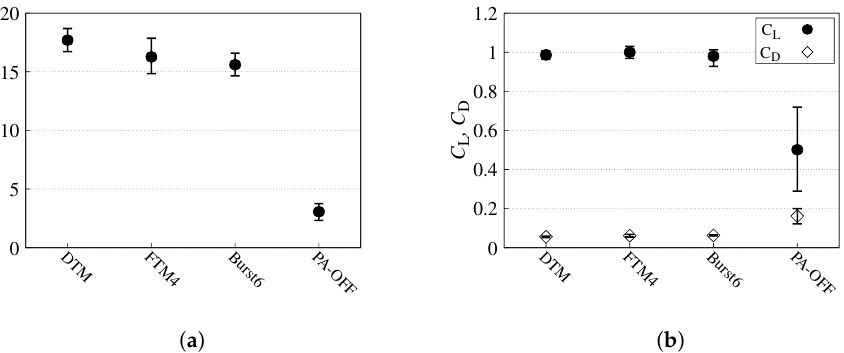
Figure 15. Aerodynamic characteristics in the DTM, FTM4, and the reference cases at α = 12. ( a ) Lift- to-drag ratio ( L / D ). ( b ) Lift and drag coefficients ( C L and C D ). The flow fields of the DTM at α = 12 and the related graphs are discussed to under- stand the flow control mechanism. Figure 16 shows that the instantaneous flow fields of the DTM and the isosurfaces and the contour surfaces are the same as in Figure 9. Figure 17 shows the time histories of L / D and C p , and the driving state of the plasma actuator from the top to bottom. The top figure overlaps with the distribution of the spanwise-averaged C p on the upper surface of the airfoil in the x / c - t domain. As shown in Figure 16, the